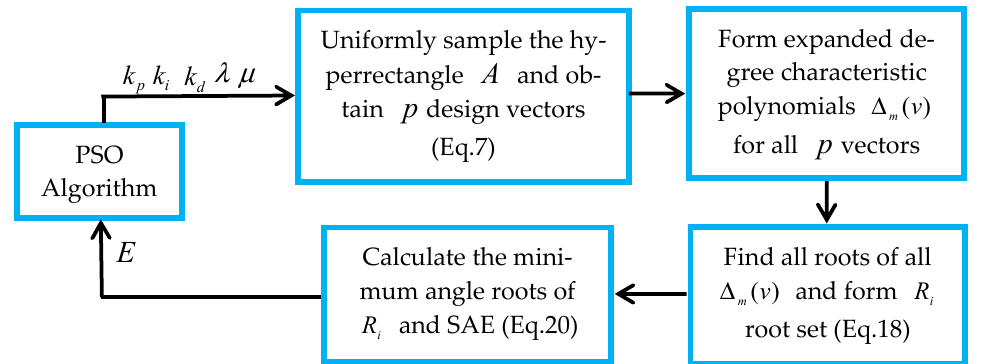
Figure 3. The block diagram describes the implication of the particle swarm optimization (PSO) algorithm for optimal robust stabilization. SAE: squared angle error.